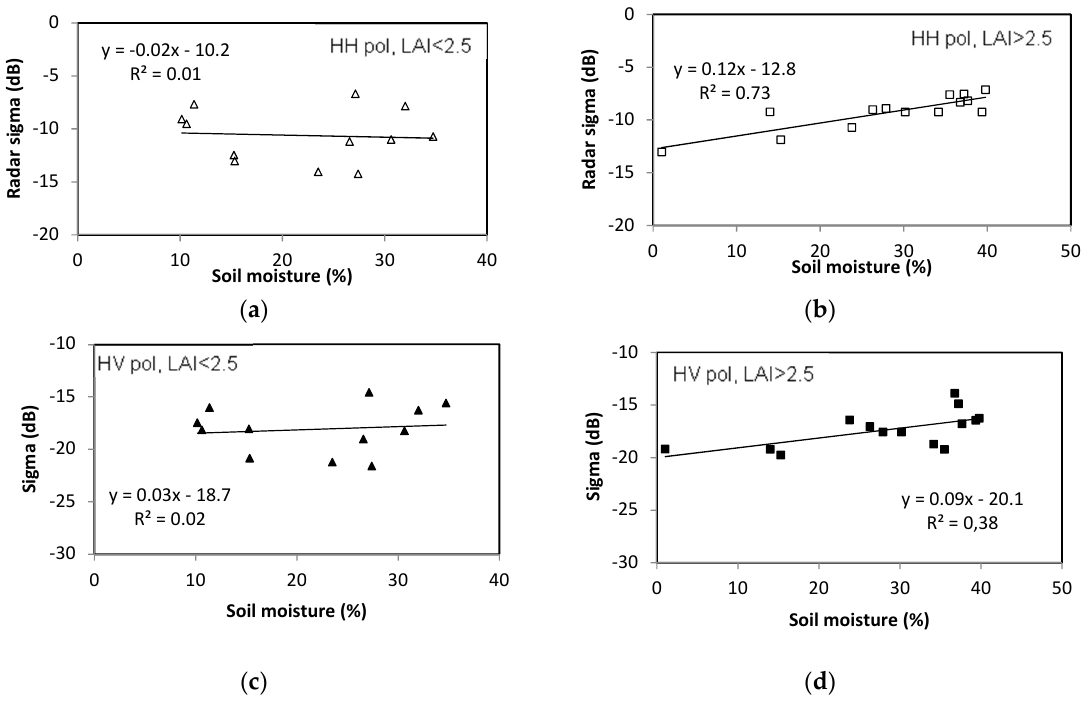
Figure 8. PALSAR radar data as a function of soil moisture for sorghum cover: ( a ) HH polarization, LAI <2.5; ( b ) HH polarization, LAI >2.5; ( c ) HV polarization, LAI <2.5; ( d ) HV polarization, LAI >2.5.